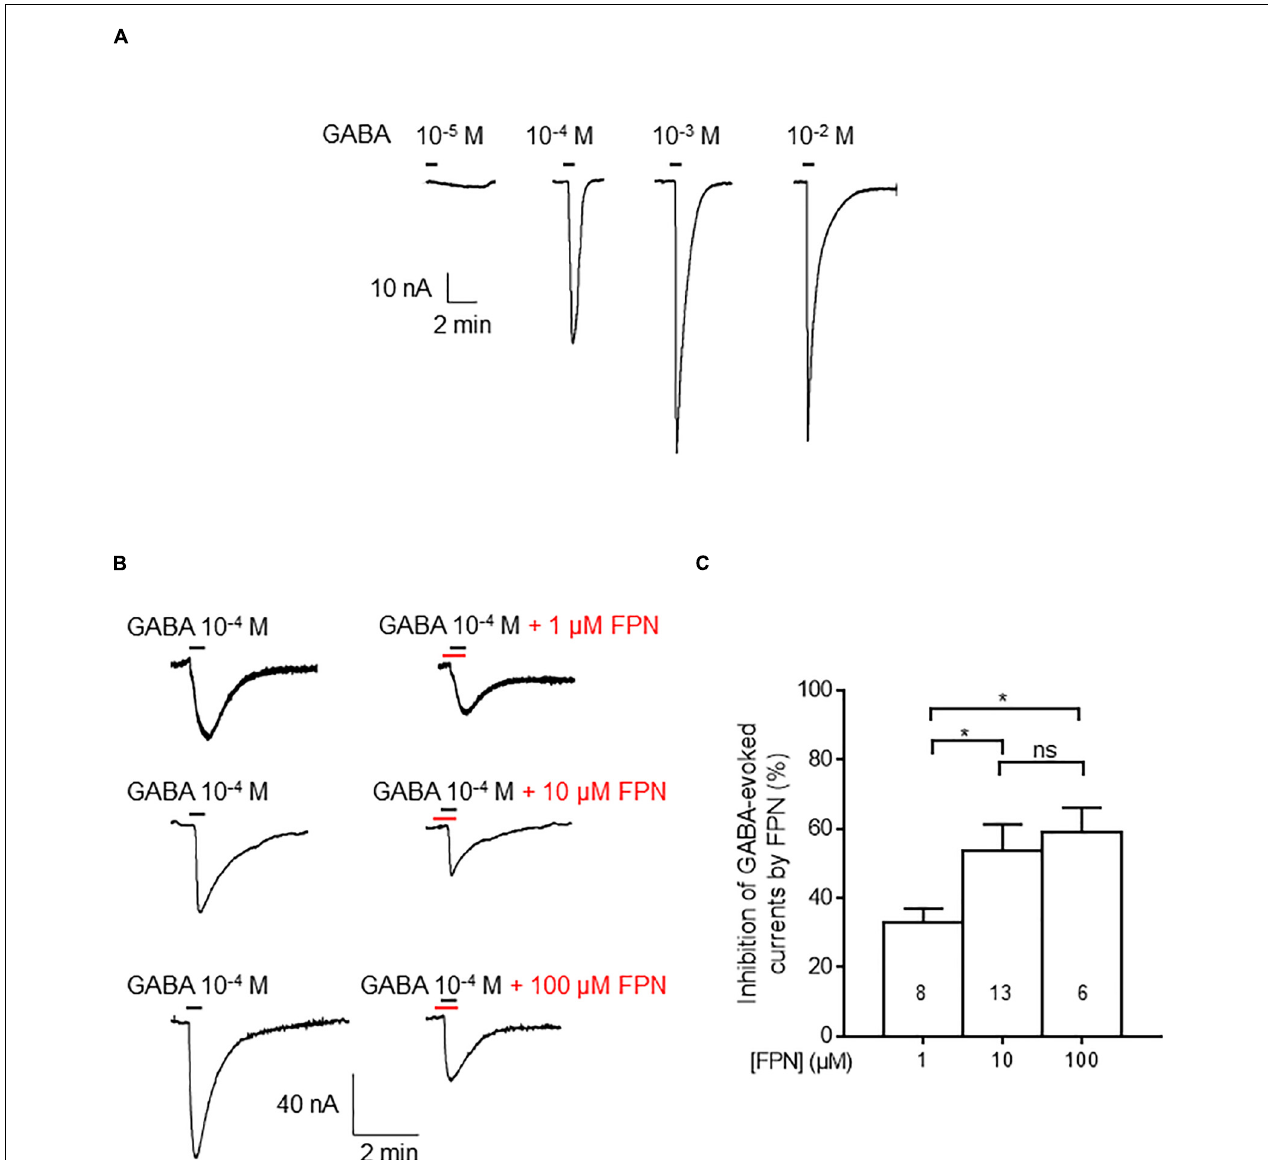
FIGURE 3 | Inhibitory effects of FPN on GABA-induced currents in membrane-transplanted oocytes. (A) Representative traces of currents evoked by increasing concentrations of GABA in an oocyte transplanted with rat cerebellum membranes. (B) Effects of FPN (1, 10, 100 µ M) on GABA-evoked currents. Control experiments denote the addition of 10 − 4 M of GABA (left), before simultaneous addition of GABA and FPN (right). (C) Histograms showing the concentration-dependent inhibitory effects of FPN on GABA-evoked currents elicited by oocyte transplantation with rat cerebellum membranes. The number of recorded oocytes is indicated inside the bars. Data are mean ± SEM. Multiple comparisons were performed using one-way ANOVA tests followed by Tukey’s post hoc correction (* p < 0.05, ns, not